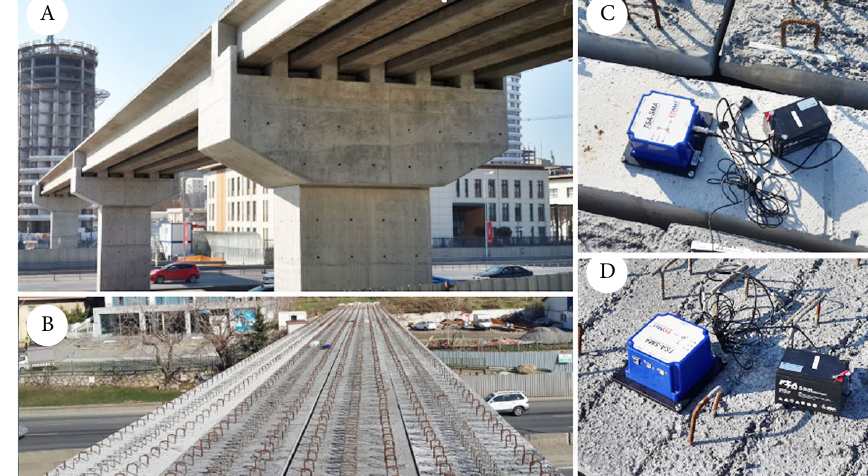
Figure 3. Modal testing on 23.01.2017 (A, B: studied bridge, C: accelerometer on a pier, D: accelerometer on mid-span)